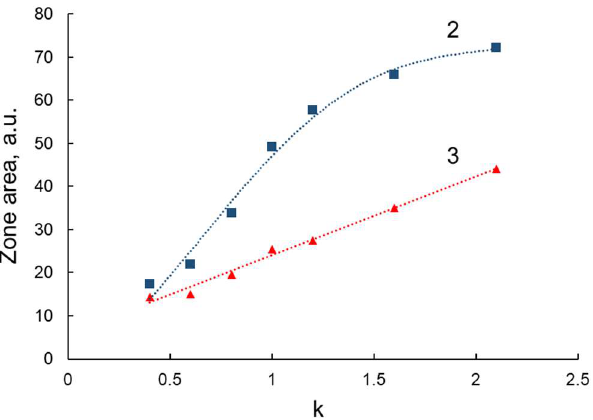
Figure 10. Relationship of sample areas of the split zones of LETI-11 (2) and complex of LETI-11 and LF (3) during electrophoresis under the presence of LF in solution, and the sum of the areas versus the ratio of components, k.